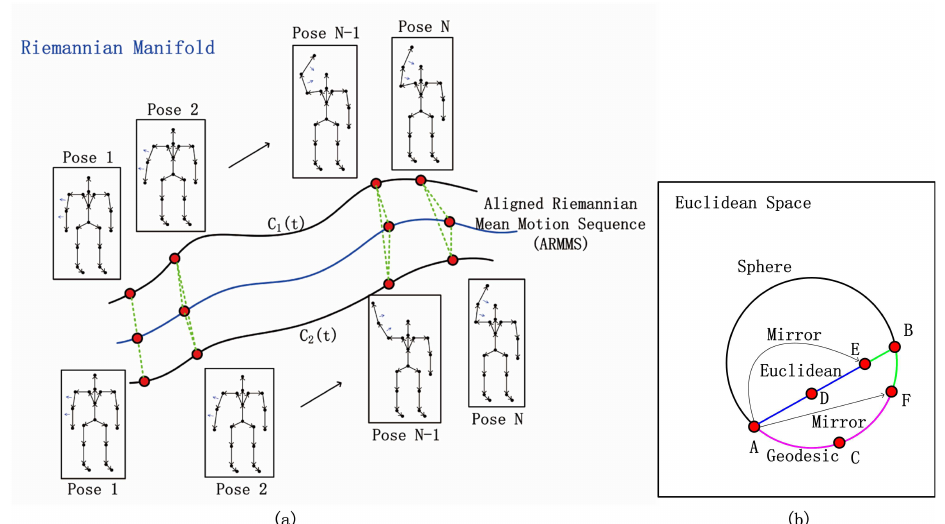
Figure 1. Illustration of the proposed ( a ) aligned Riemannian mean motion sequence (ARMMS). ( b ) A and B are the pair of poses in two different sequences C 1 ( t ) and C 2 ( t ) . C and D are the mean points on the sphere and plane, respectively. F and E are mirrors of A for manifold and Euclidean cases, respectively. The difference between A and B in the green on the sphere is larger than in the case on the (cid:95) BF > BE Euclidean plane, i.e., geodesic